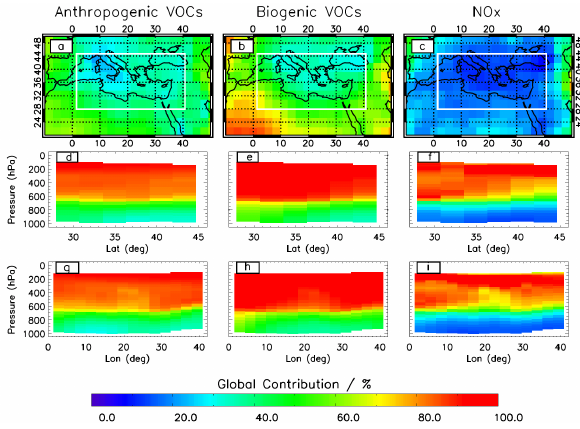
Fig. 7. Contribution of global emissions (%) to changes in mean summertime (JJA) ozone for three precursor species emissions (from left to right: anthropogenic VOC, biogenic VOC and NOx). The top row shows the contributions to surface level ozone over the Mediterranean region. The middle row shows zonal means of the contribution within the white boxes depicted in the maps on the top row. The bottom row shows meridional means of the contribution, also within the white boxes. For zonal and meridional mean plots, only tropospheric model grid boxes are plotted (determined as where potential temperature < 380 K and PVU <2).